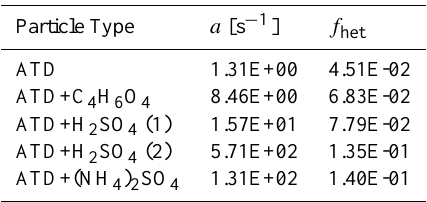
Fig. 8. Immersion freezing behavior of all types of examined parti- cles. Each data point was measured at least three times (with 1000 to 10000 particles for each measurement) and the error bars repre- sent the respective standard deviations. The line at T s =38K sepa- rates the heterogeneous (on the left) and homogeneous (on the right) freezing modes. Table 1. Parameters a and f het of the CNT type nucleation rate expression for the immersion freezing of supercooled water droplets containing different types of IN.